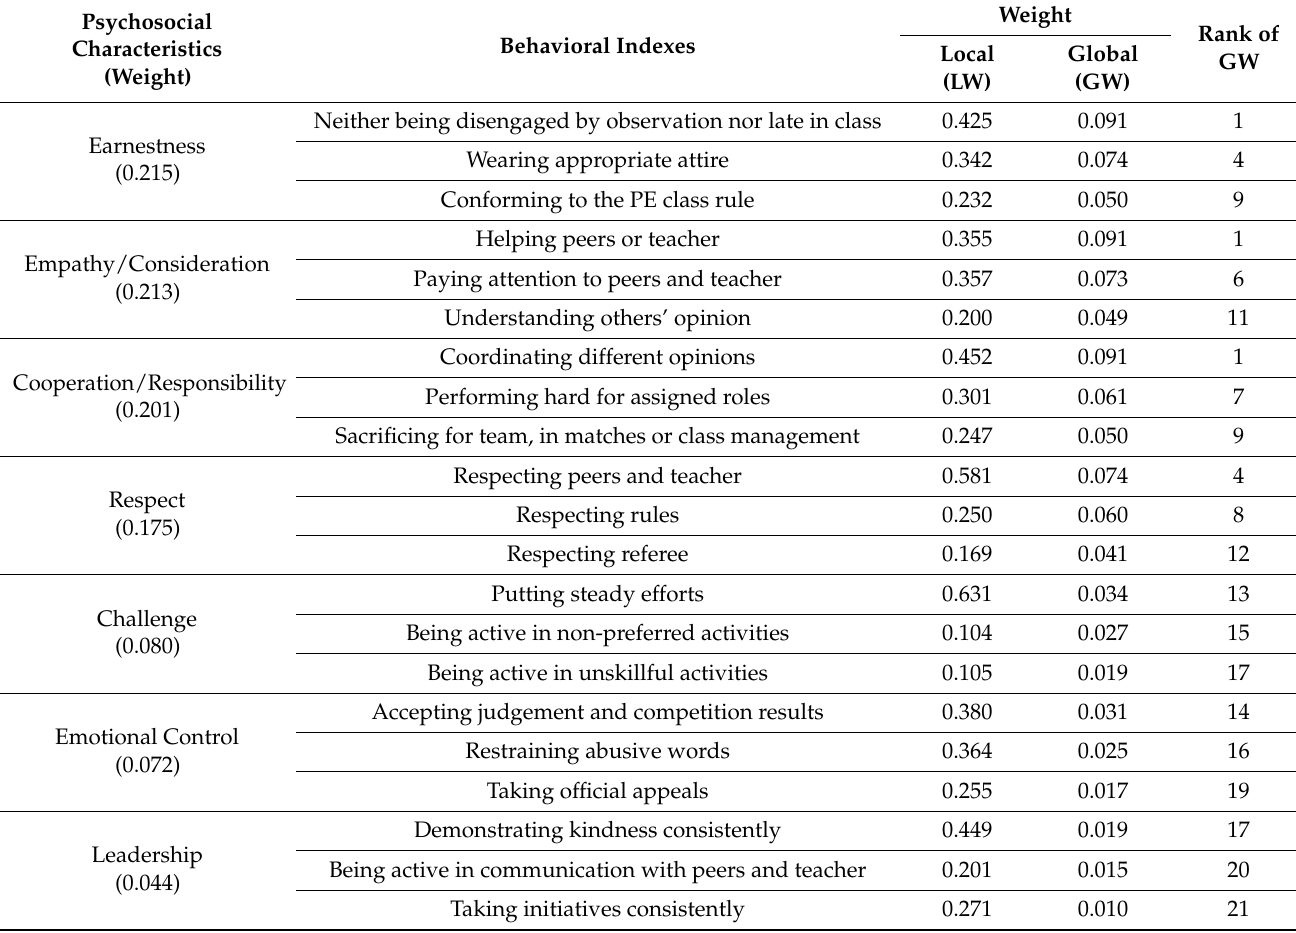
Table 6. Weight and Rank of Behavioral